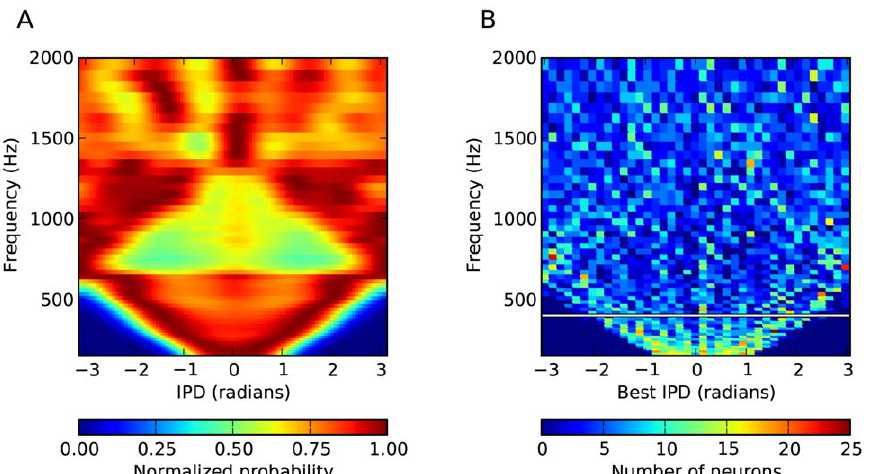
Figure 14. Distribution of interaural phase differences (IPD) in the binaural signals and preferred IPDs of binaural neurons. The color codes follow the conventions of Fig. 3 of Harper and McAlpine (2004). (A) Distribution of IPDs across all HRTFs (including all measured azimuths and elevations), as a function of frequency. The dark triangle corresponds to the physical limit of ITDs, which is smaller than half a period for low frequencies, while the light triangle corresponds to the situation when the maximum ITD is between p and 2 p , which makes larger IPDs more represented than smaller ones (imagine folding a larger triangle at the vertical lines IPD= 2 p and IPD= p ). (B) Distribution of best IPDs of neurons in the approximate model as a function of their preferred frequency. Best IPDs were measured using delayed white noise. The horizontal line at 400 Hz represents the frequency above which best delays should be continuously distributed, according to Harper and McAlpine (2004). A very similar distribution was obtained with the ideal model (not